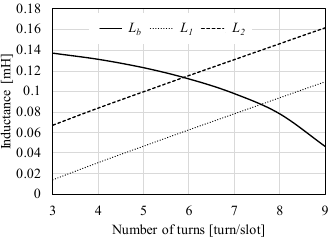
Figure 6. Relationship between output torque and number of turns.